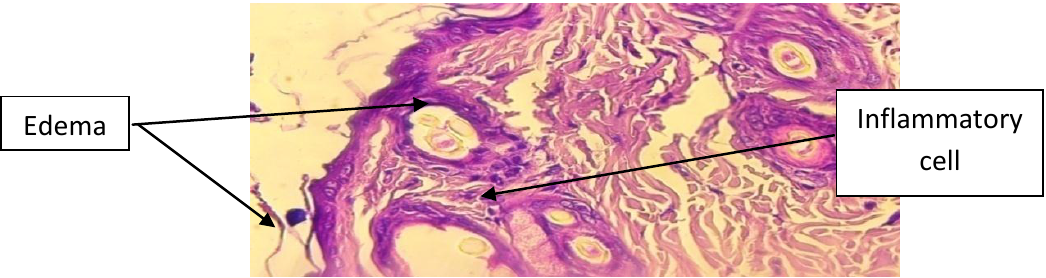
Figure (6): Section of skin specimen of mouse infected by S. aureus treated with combination of T. Foenum-